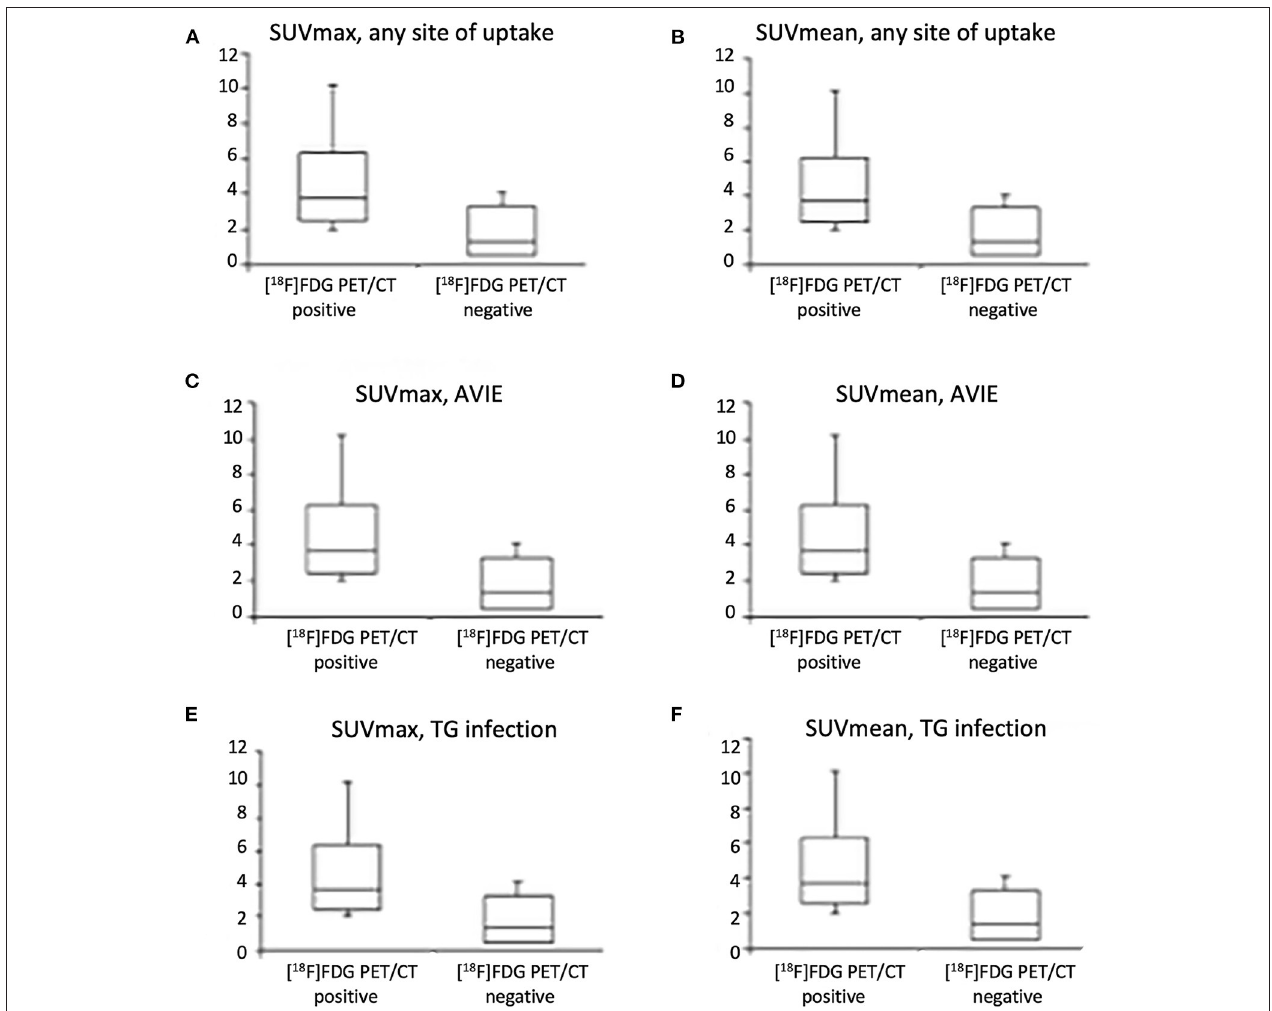
FIGURE 4 | Box plot shows maximum standardized uptake value (SUVmax) and SUVmean in our cohort when considering any site of uptake (A,B) , uptake at valve site consistent with IE (C,D) , and uptake in infected and non-infected vascular prosthesis infection (VPI) (E,F)